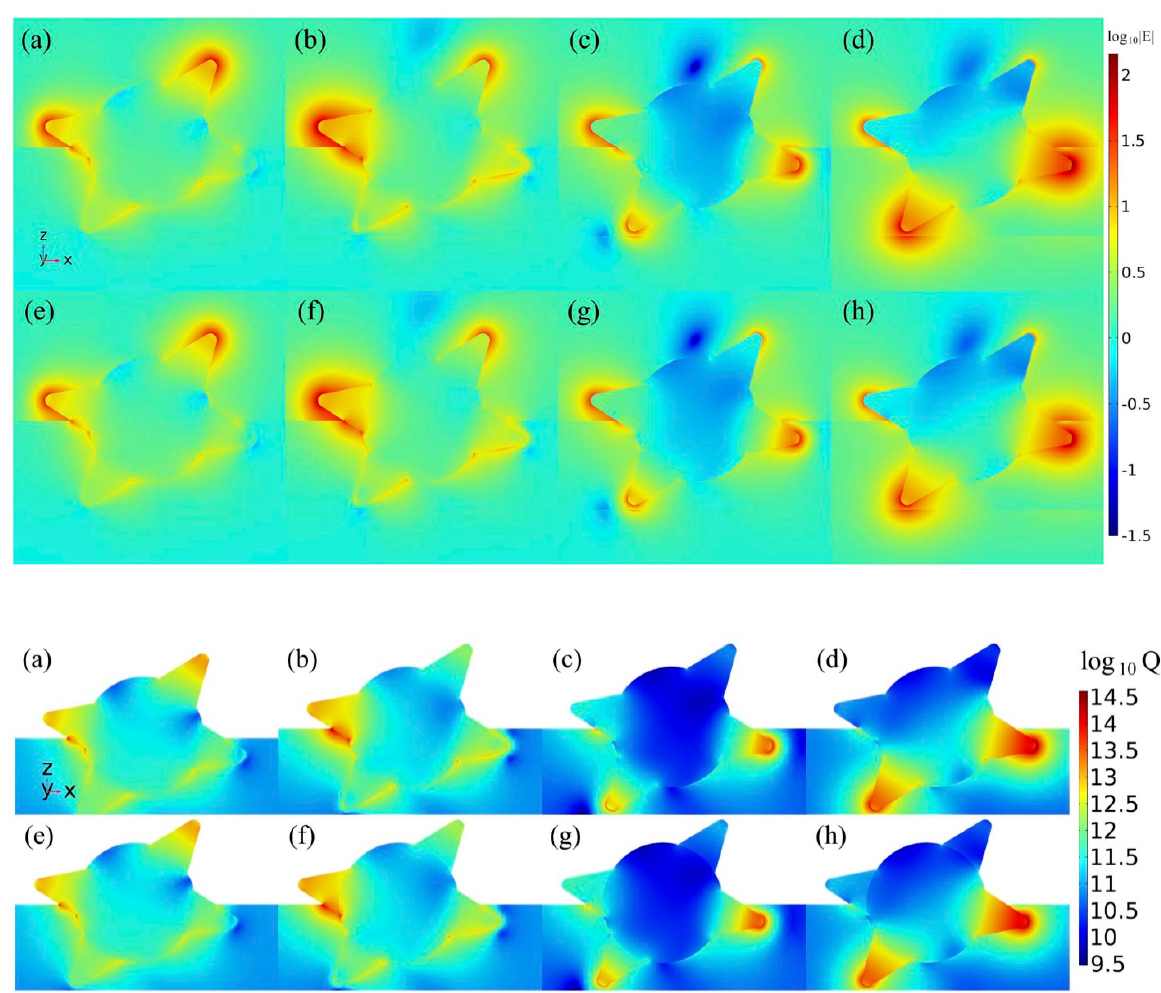
Figure 5. 2D maps of normalized electric field (upper panel) and specific radiation absorption power Q under an irradiation field of intensity I 0 = 1 W/cm 2 (lower panel) in an HM slice at 584 nm ( a , e ); 634 nm ( d , f ); 808 ( c , g ); 970 nm ( d , h ) calculated for bulk ( a – d ) and size-corrected ( e – h ) dielectric function of spikes.